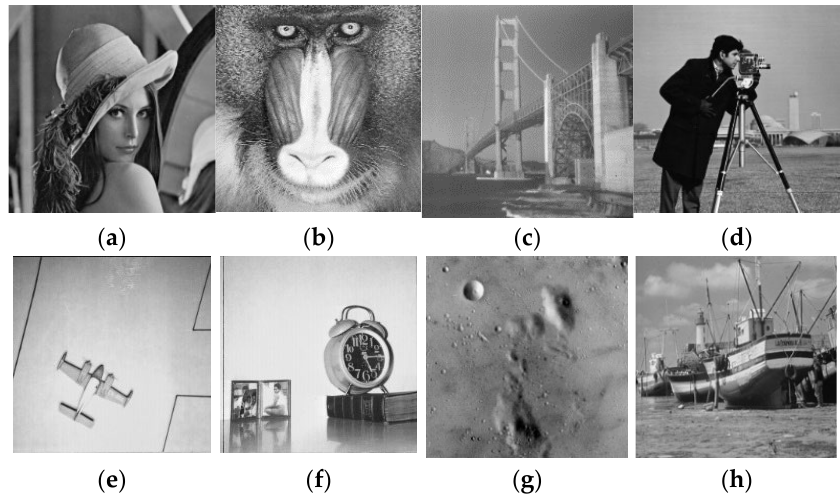
Figure 7. Decrypted images: ( a ) Lena; ( b ) baboon; ( c ) bridge; ( d ) cameraman; ( e ) airplane; ( f ) clock; ( g ) moon; ( h ) ship.